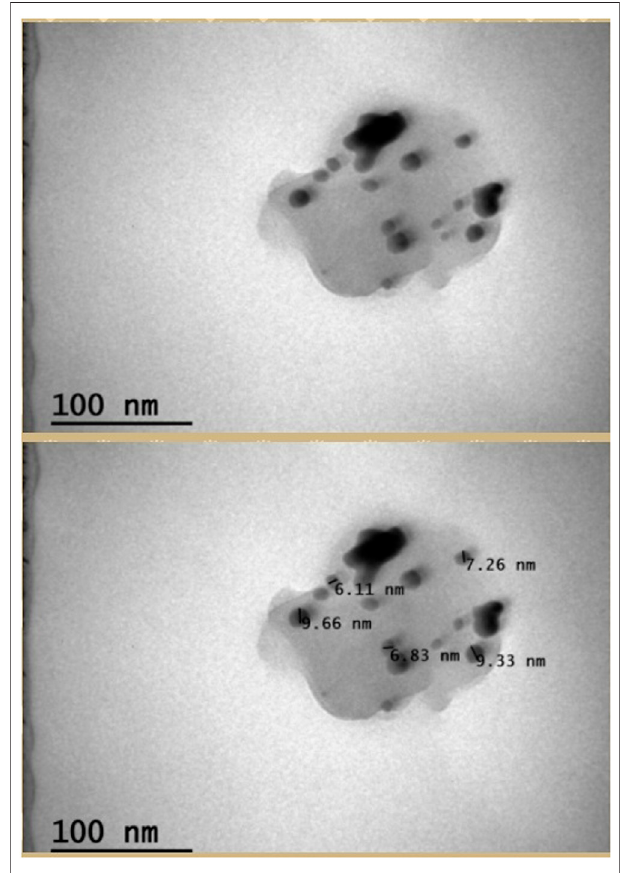
FIGURE 4 | TEM results of